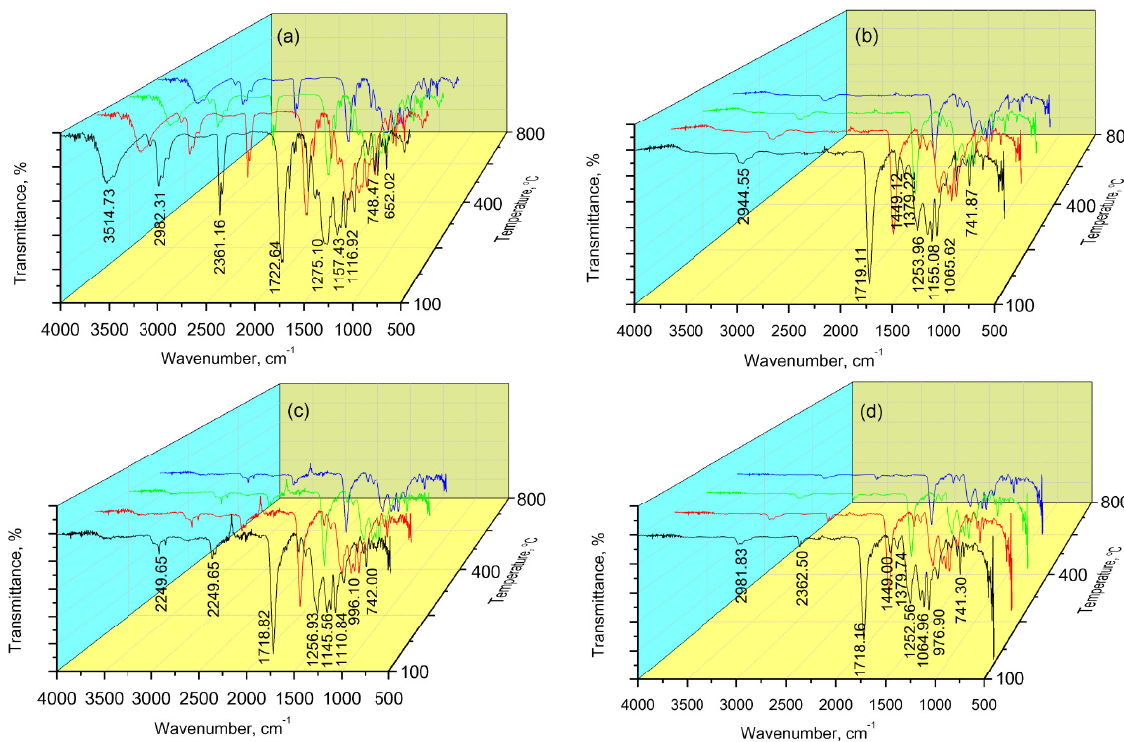
Figure 3. IR spectrums of p-PGFPh:АА decomposition products at ratios М 1 :М 2 , mol.%: ( a )−p-PGFPh; ( b )−6.77:93.23; ( c )−44.17:55.17 and ( d )−86.67:13.33 recorded at temperatures between 0 and 800 °С.